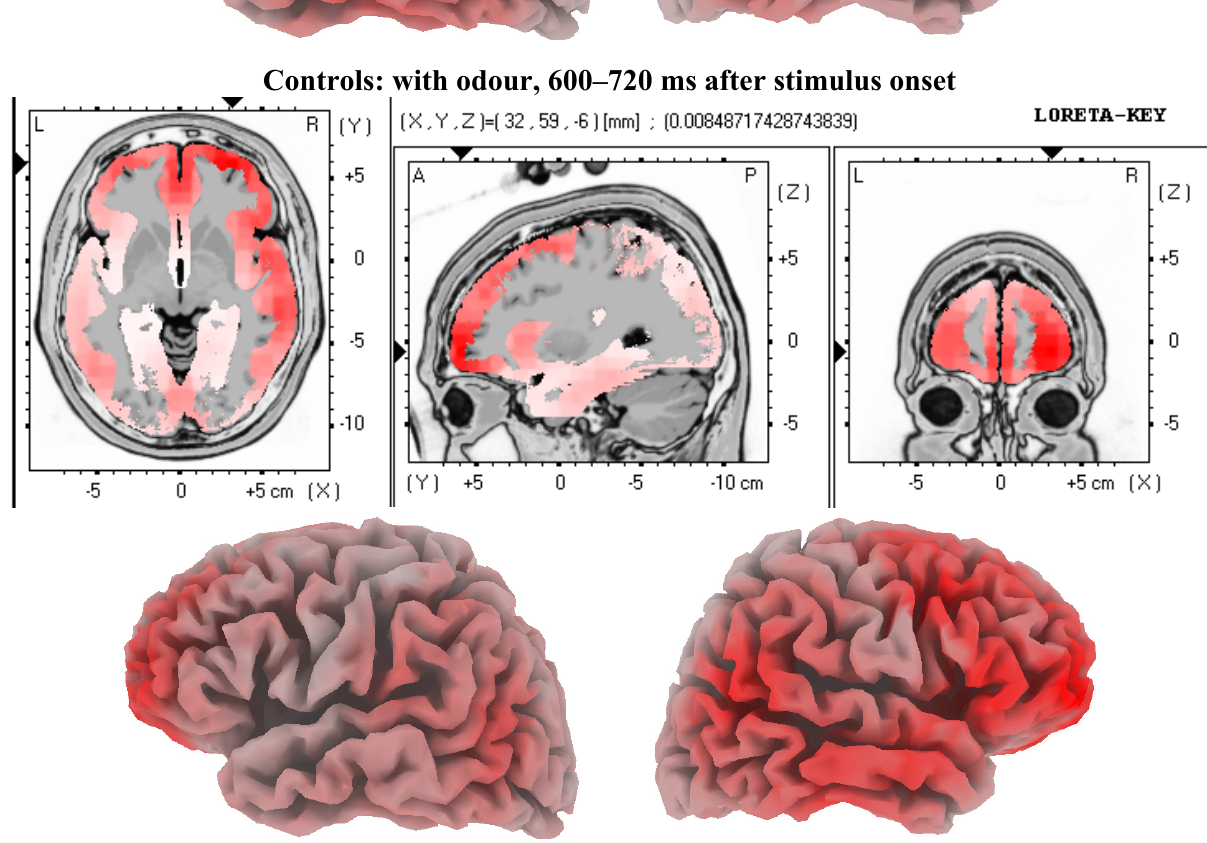
Controls: with odour, 600–720 ms after stimulus